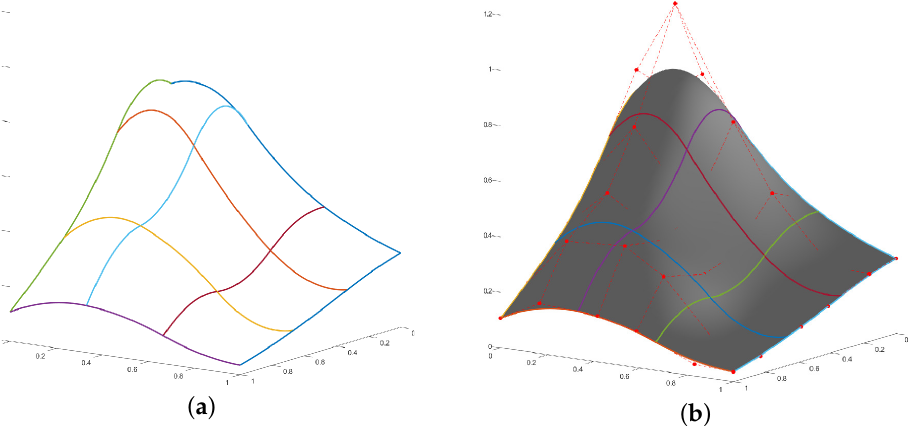
Figure 14. ( a ) The curve network with m = n = R = S = 2 and ( b ) the Gordon-type surface interpolating it.